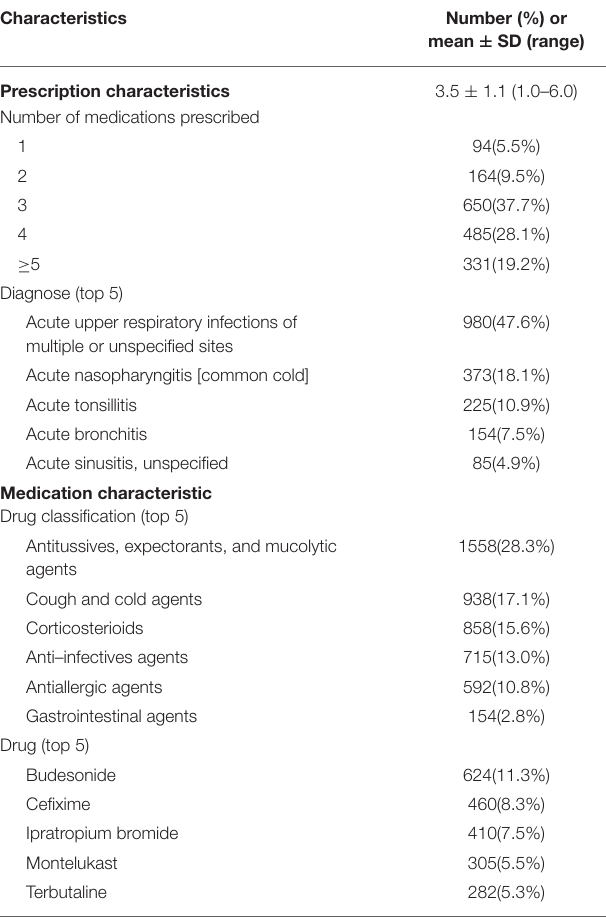
TABLE 3 | The characteristics of included prescriptions and the drug items in this study.